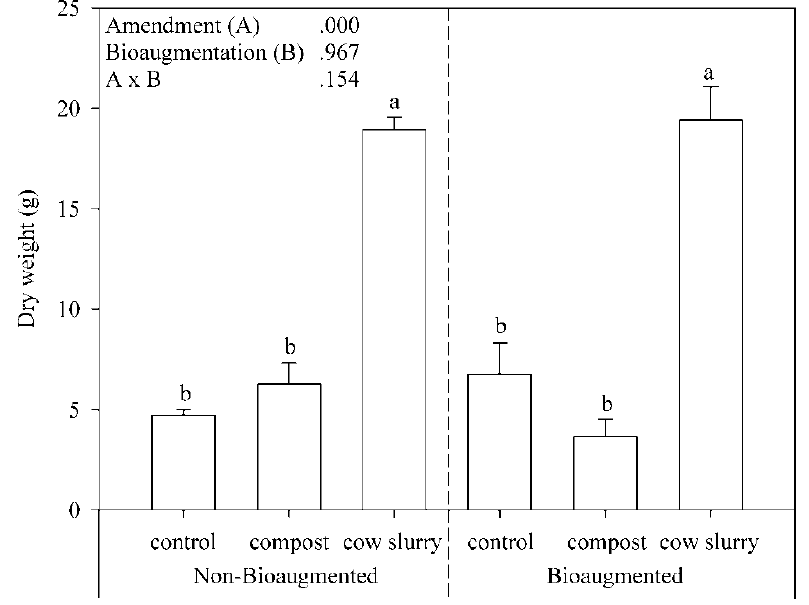
Figure 1. Dry weight (g) of B. napus plants. Compost: amended with composted horse manure; Cow